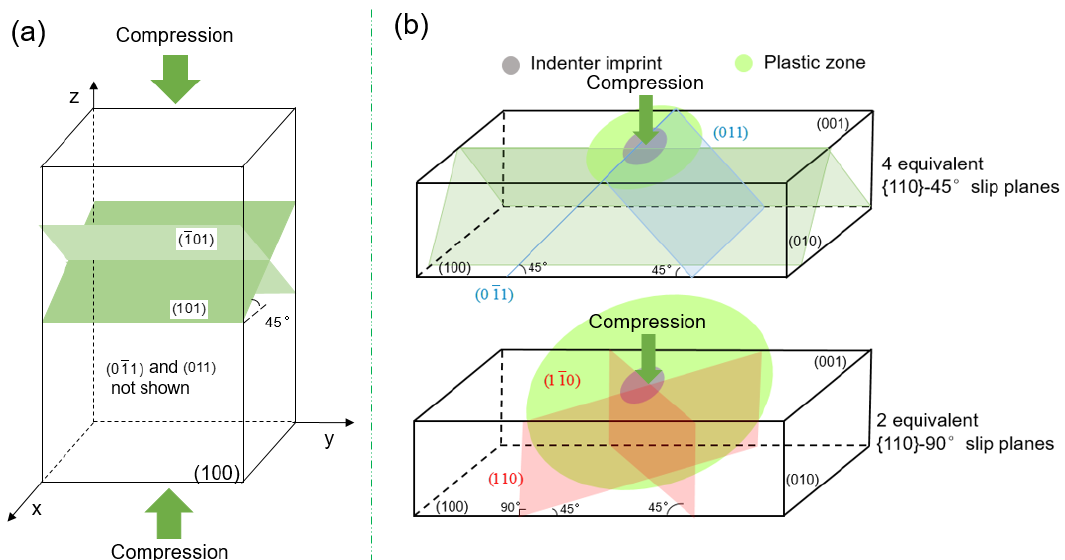
Figure 4. Comparison of the activation of slip systems: ( a ) slip activation in bulk compression along [001] direction; ( b ) slip activation in indentation test on (001) surface, note the angles 45° and 90° indicate the inclined angle between the slip plane and the indented surface.